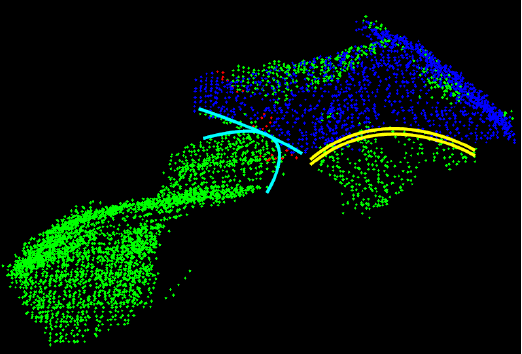
Figure 7. Edge-based region merging: neighbouring segments belong to the same leaf, if their border edges describe the same space